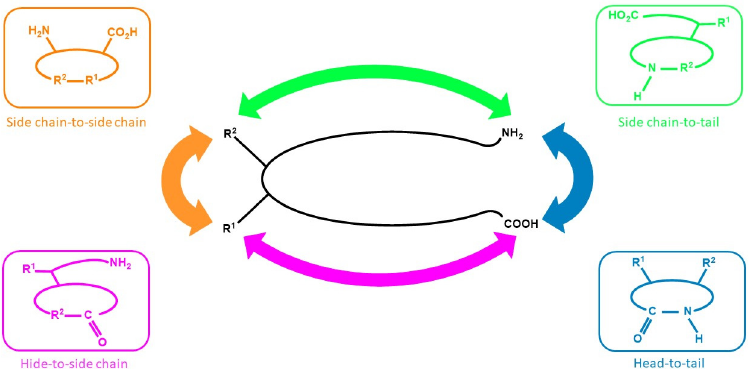
Figure 1. Cyclic peptides in general.